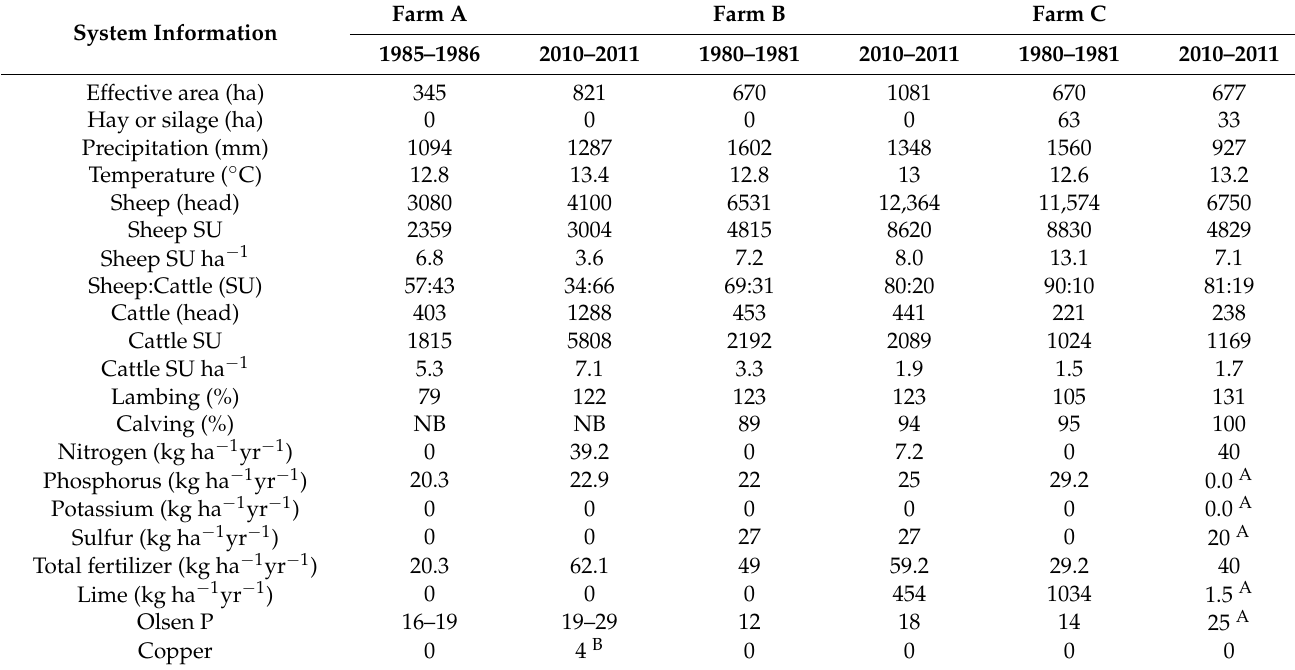
Table 2. Changes in effective area, number of sheep and cattle, animal stock units (SU), lambing and calving percentages, and chemical inputs on the case-study farms from the 1980s to